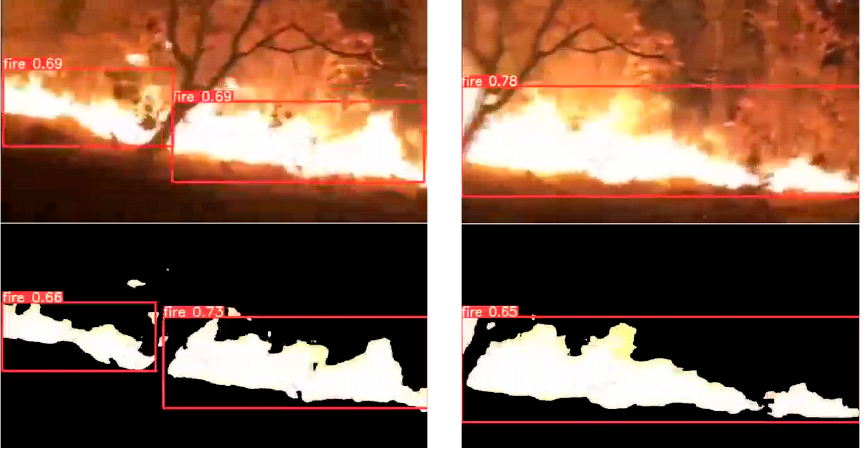
Figure 7. Recognition effect of Y4SED model on pictures containing interferences (sun). ( a ) The model has no false detection and strong anti-interference ability; ( b ) The model has no false detection and strong anti-interference ability.